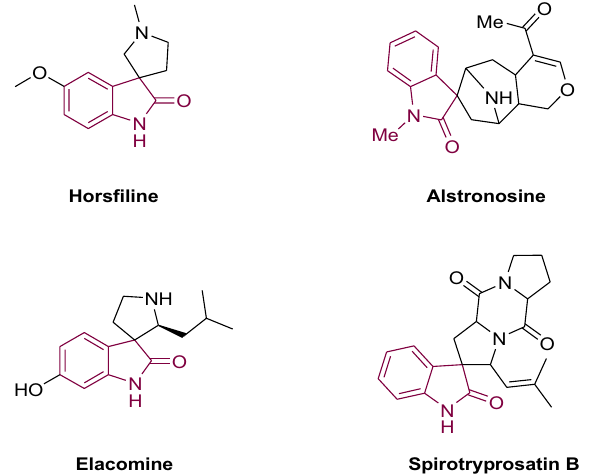
Figure 1. Selected spirooxindole natural products.